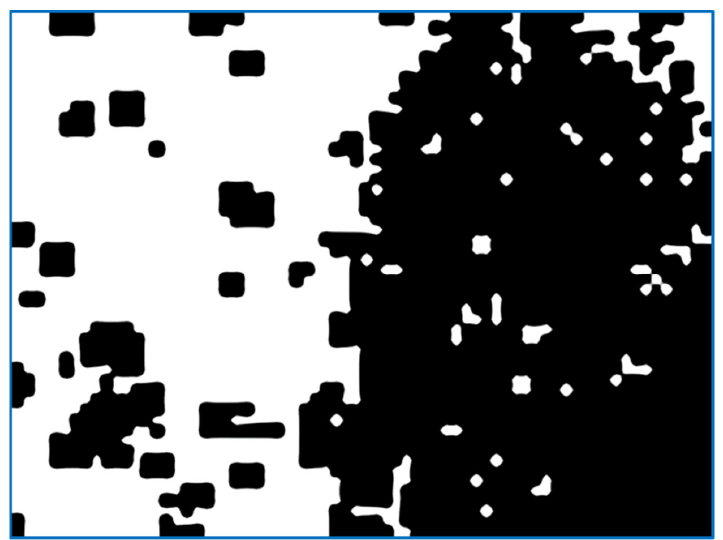
Figure 7. The result of feature extraction is obtained by computing the entropy of information, which represents the brightness distribution over a 64 × 64 fragment with 32 pixels step.